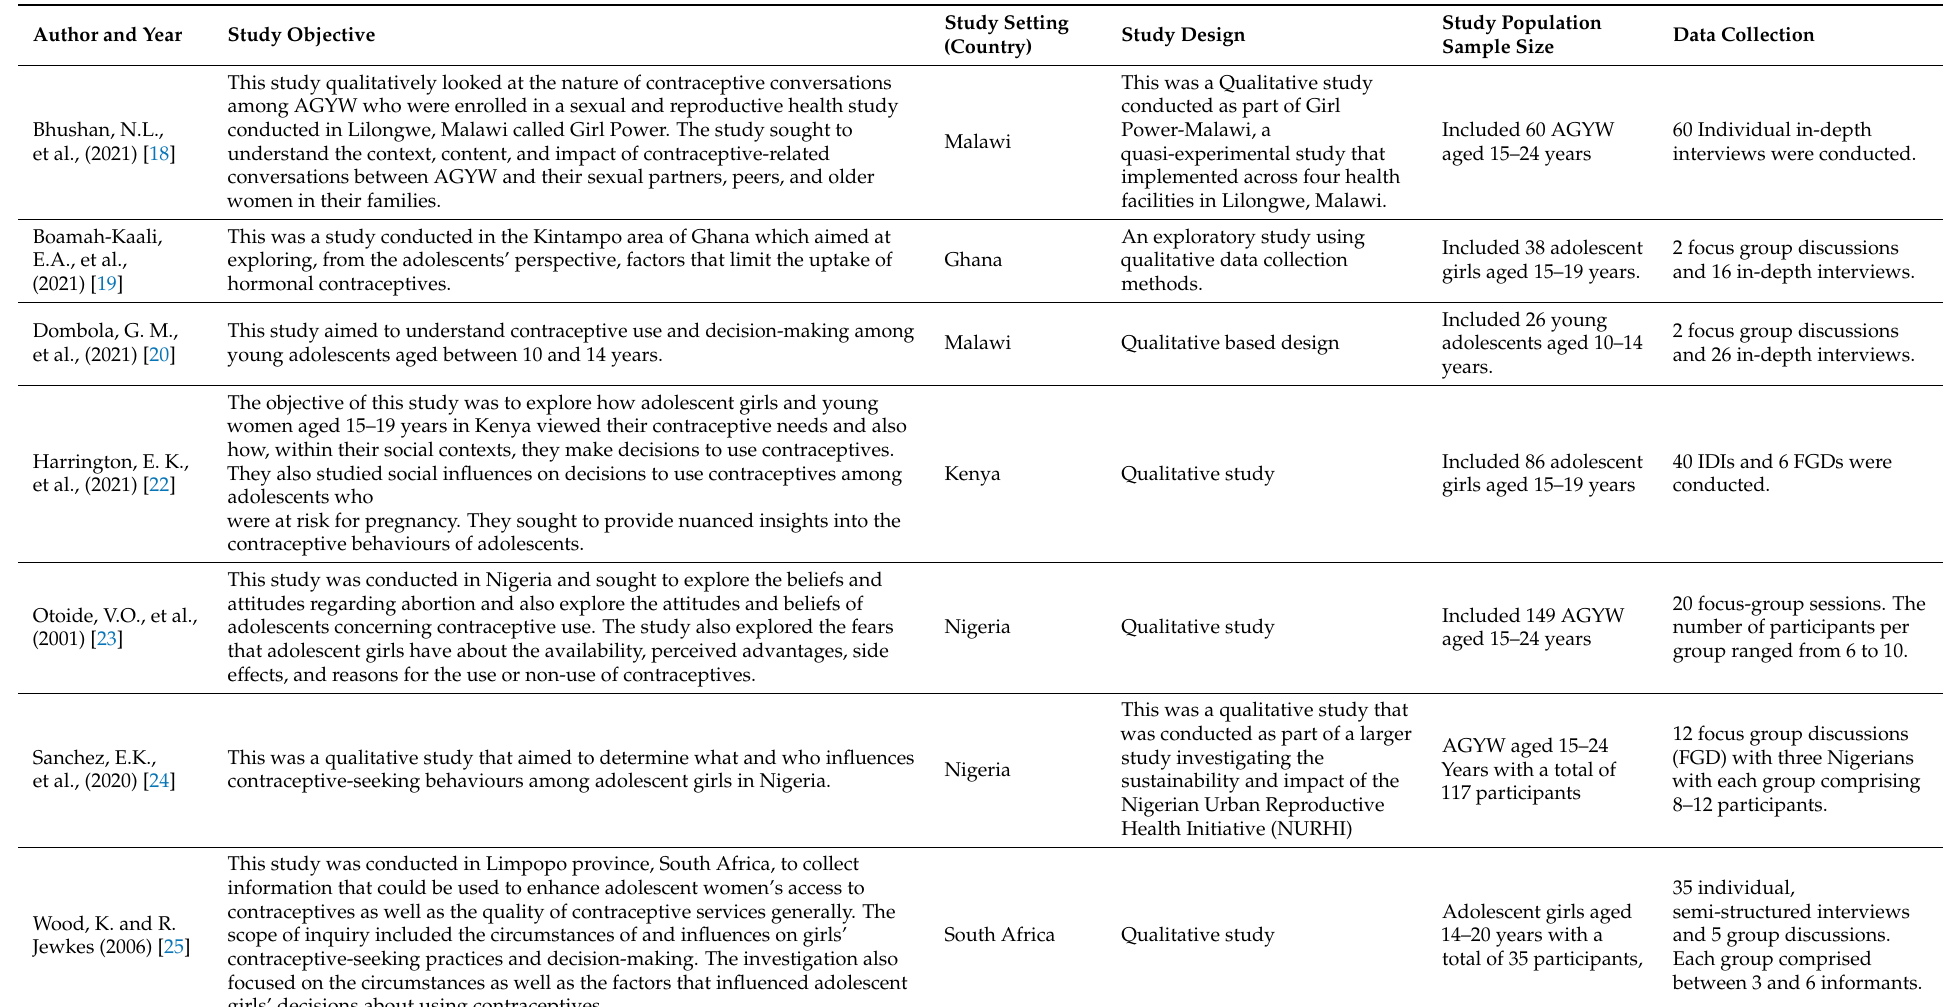
Table 4. Characteristics of included